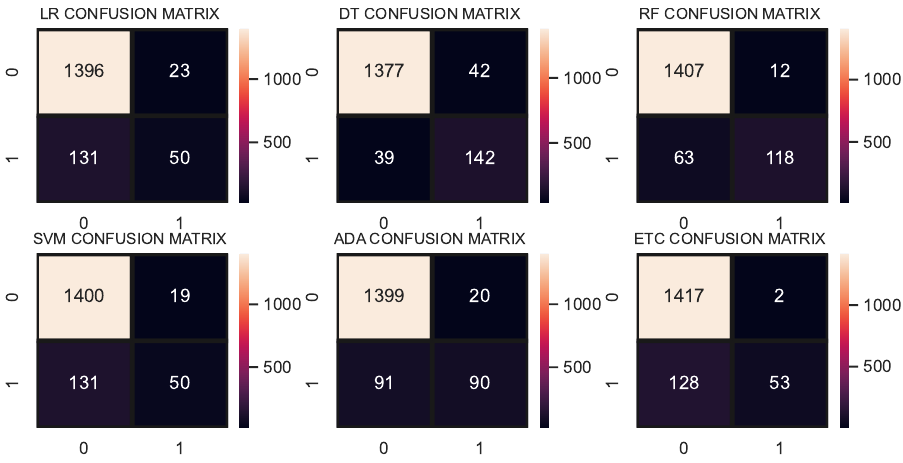
Figure 5. Confusion matrices for machine learning models showing correct and wrong